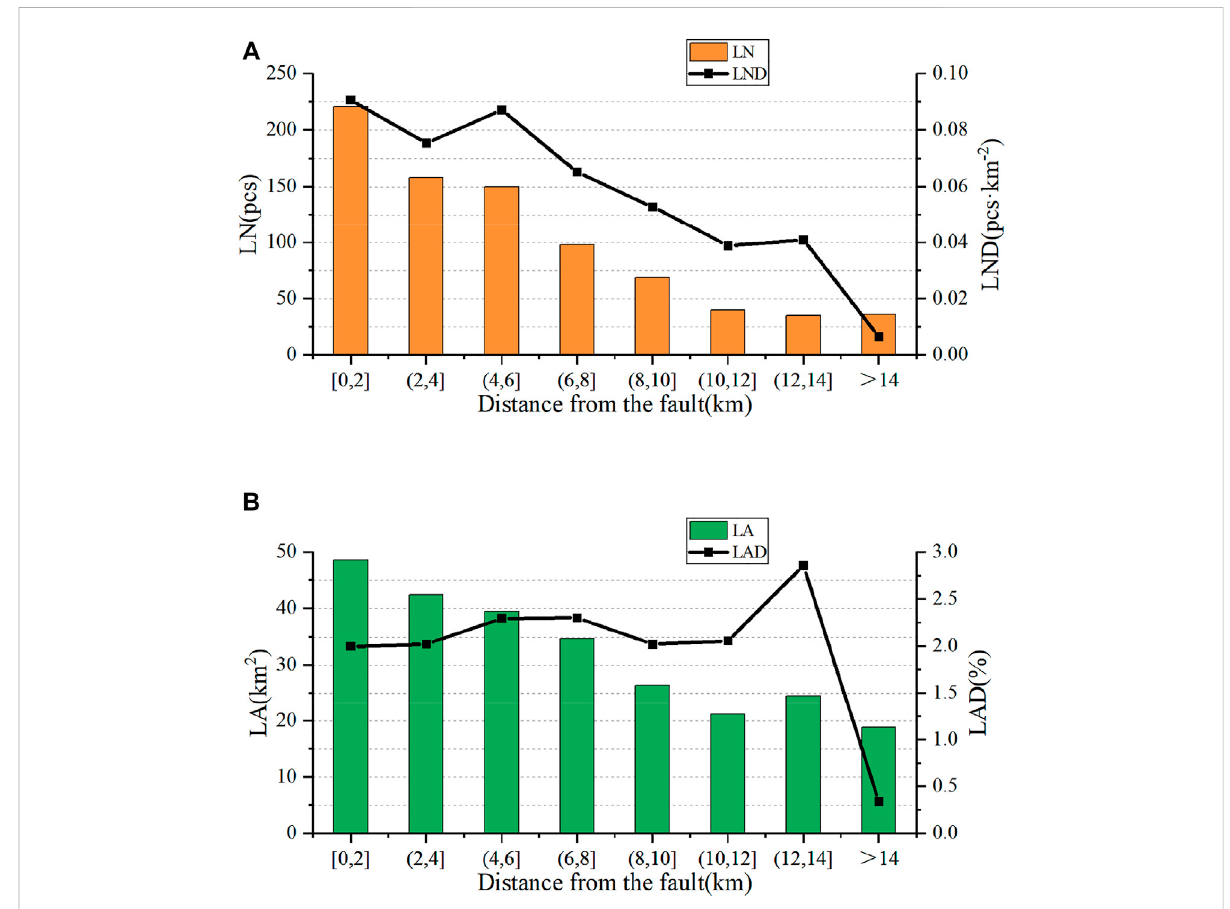
FIGURE 8 The correlations between distance from the fault and landslide distribution. (A) LN and LND; (B) LA and